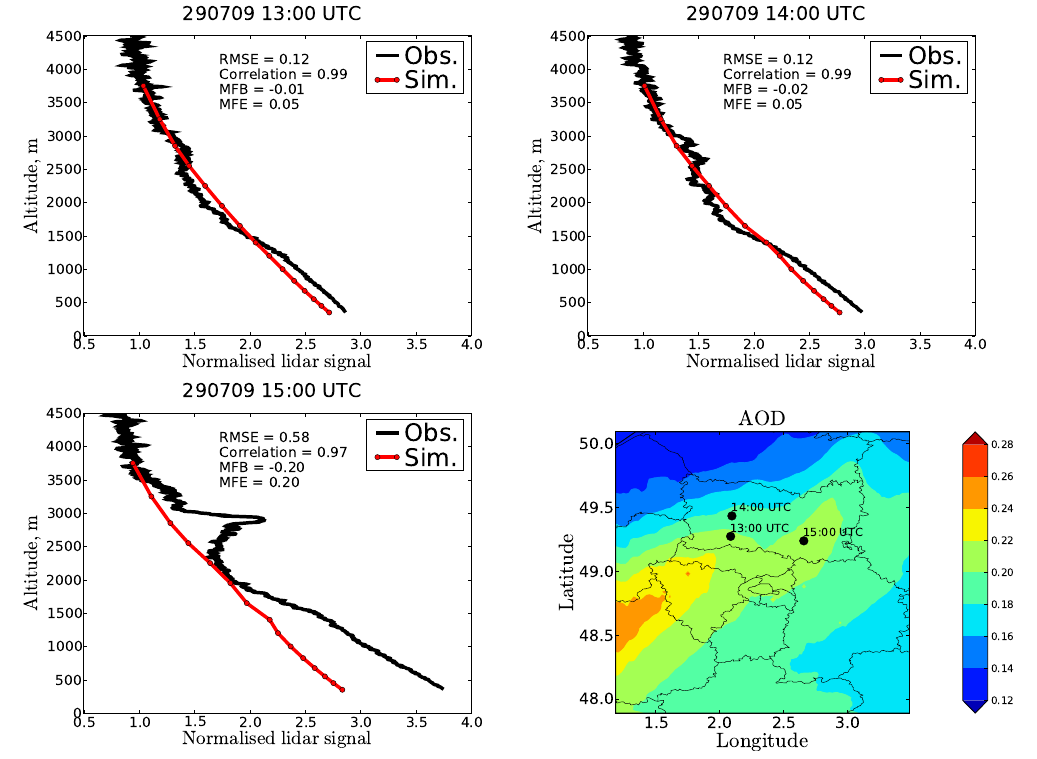
Fig. 9. Comparisons between the vertical profiles observed by GBML (black lines) and simulated by P OLYPHEMUS (red lines) on 29 July 2009 at 13:00, 14:00 and 15:00UTC. Lidar observations below the altitude of full overlap are not represented. The lower-right panel shows the positions of the different lidar profiles and the horizontal distribution of the mean of the AODs at 13:00, 14:00 and 15:00UTC.